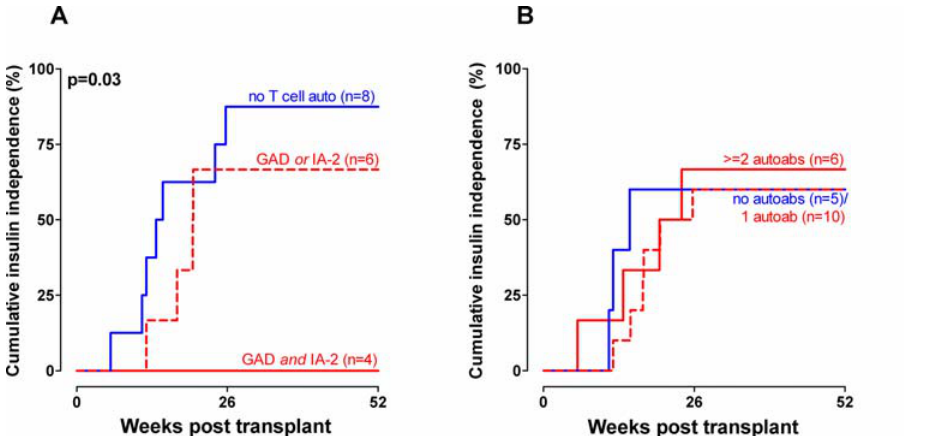
Figure 2. Kaplan-Meier curves showing cumulative insulin independence after b -cell transplantation, stratified for A) pre- transplant cellular autoimmunity and B) pre-transplant presence of autoantibodies. Continuous lines represent patients without reactivity to autoantigens, striped lines patients with reactivity to a single antigen, and dotted lines patients with reactivity to two antigens (or three in the case of autoantibodies).